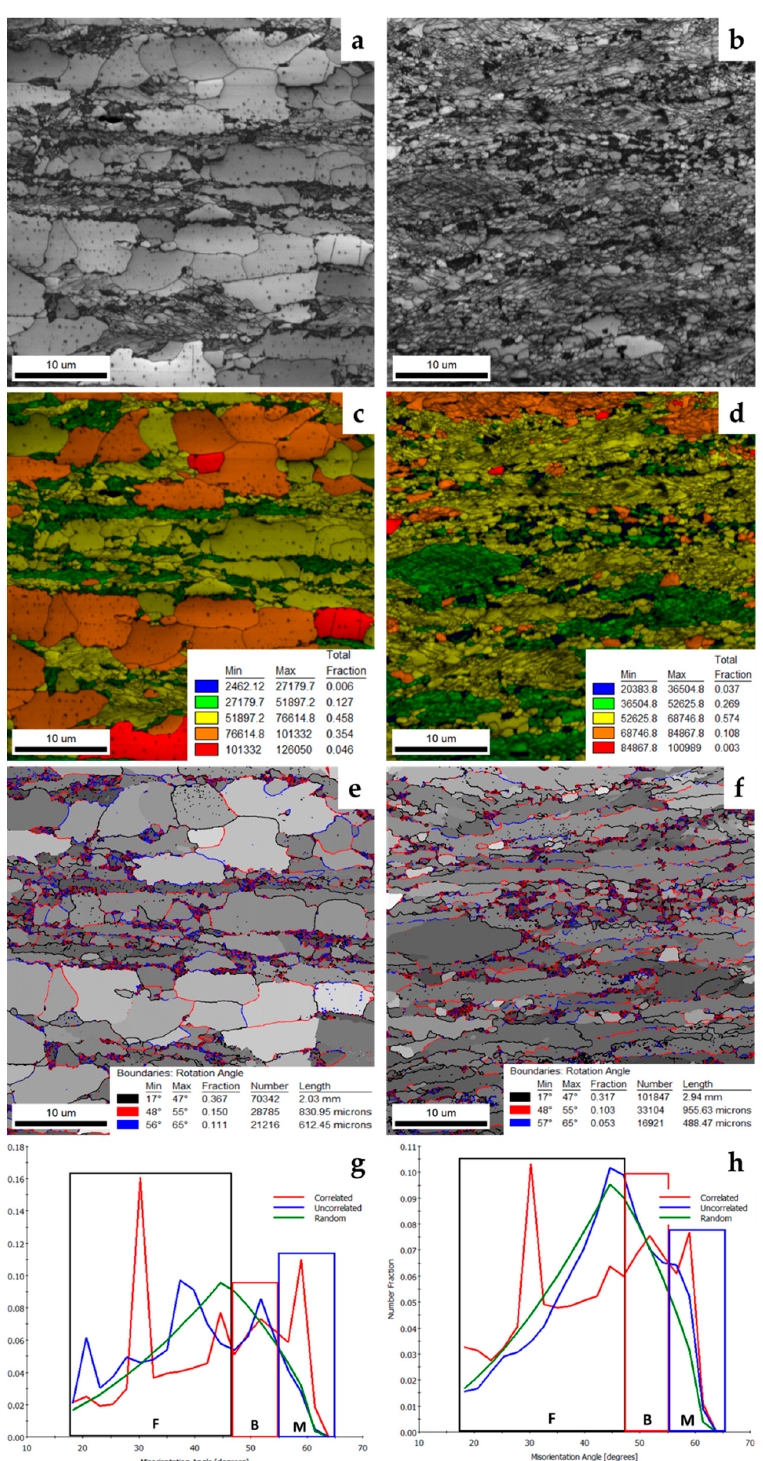
Figure 6. Grayscale image quality (IQ) map of the CH ( a ) and UFH ( b ) sample showing the region of the electron back-scatter diffraction (EBSD) scan. Color-coded grain average image quality (GAIQ) map for the ( c ) CH and ( d ) UFH sample. Martensite is indicated in dark green and ferrite in red/orange/yellow colors, gray-scale GAIQ map of the same areas of the CH ( e ) and UFH ( f ) with misorientation angles indicating the boundaries between prior austenite grains (PAGs; black), bainite (red) and martensite (blue). The misorientation angle charts for the CH ( g ) and UFH ( h ) samples indicate the fraction of each constituent shown in the previous maps.